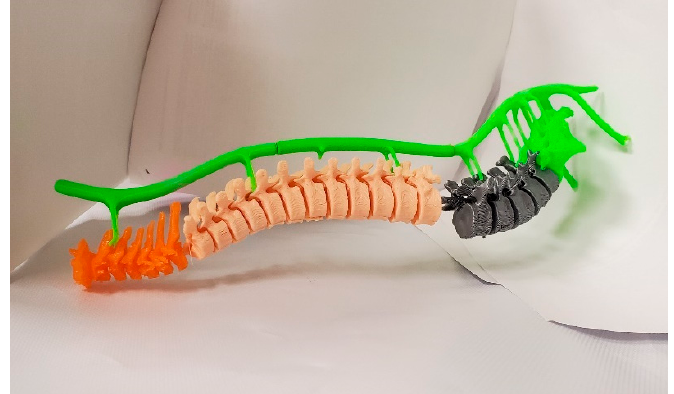
Figure 5. Spinal cord model [68].